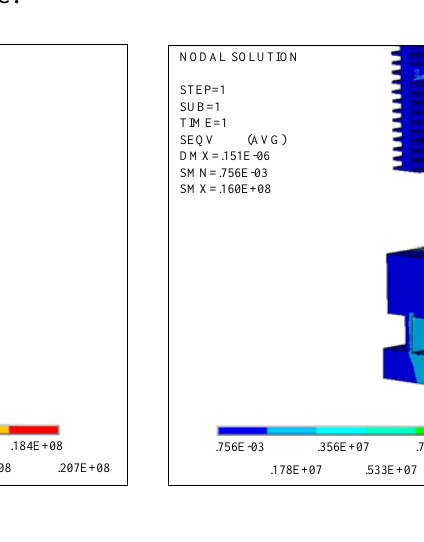
Figure 4. The stress distributions of the two DETF structures when the ambient temperature decreases from room temperature to −40 °C. ( a ) The common DETF structure; ( b ) The improved DETF structure.